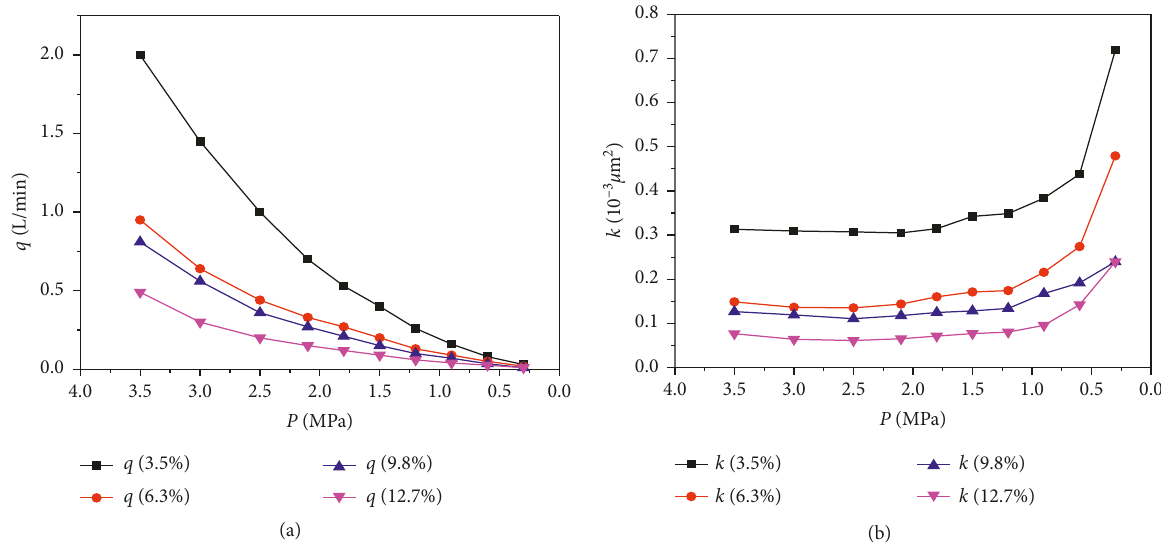
Figure 5: Plots of (a) gas pressure-flow rate and (b) gas pressure-permeability with different moisture contents during gas depressurization extraction.